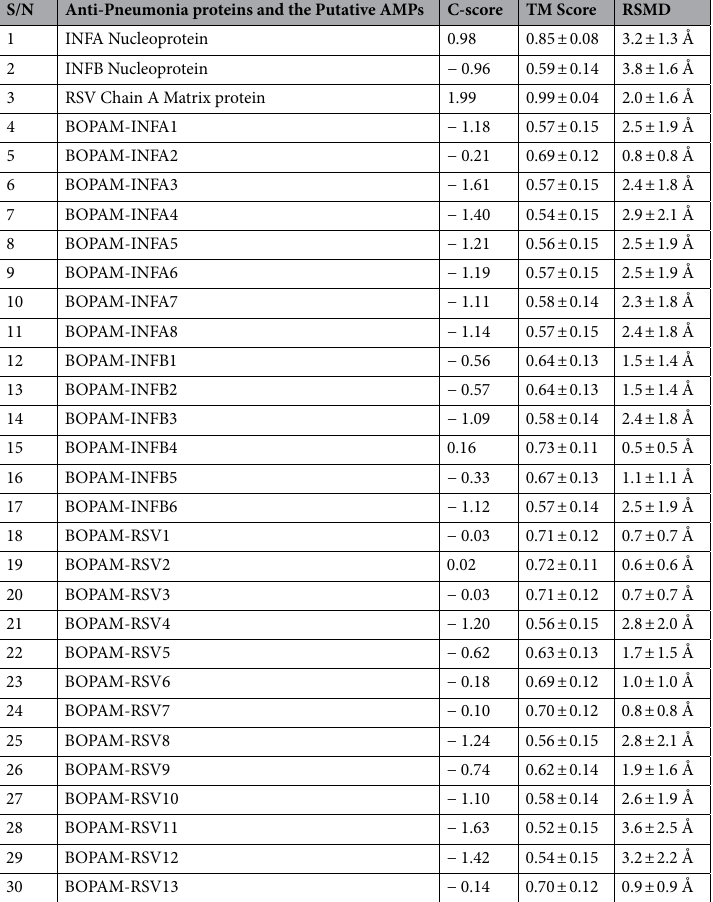
Table 7. Quality assessment scores of the predicted 3-D structures of the pneumonia receptors and the putative anti-pneumonia AMPs. S/N serial number, INFA Influenza A virus, INFB Influenza B virus; RSV Respiratory Syncytial virus. BOPAM-INFA anti-Influenza A virus AMPs, BOPAM-INFB Anti-Influenza B virus AMPs, BOPAM-RSV anti-Respiratory Syncytial virus AMPs, C-score Confidence score; TM score Template Modeling score, RMSD root-mean-square